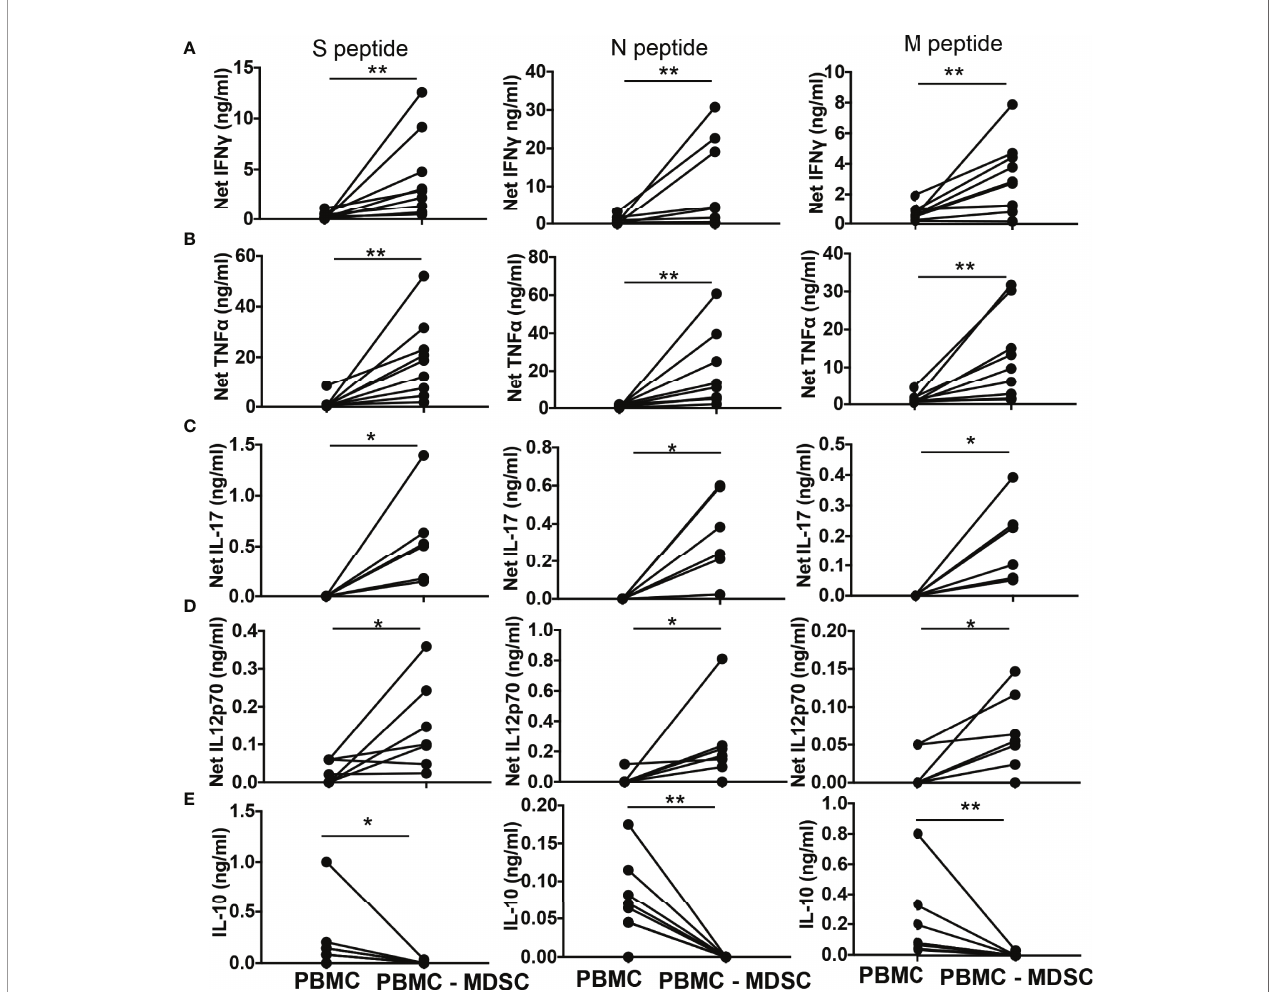
FIGURE 4 | M-MDSC regulates CoV2 antigen-speci fi c T cell cytokine production: (A – E) Freshly isolated PBMC from CoV2+ individuals were stained with anti-CD14 and -HLA DR antibodies; CD14 + HLA DR -/lo M-MDSC were depleted from PBMC by fl ow cytometry. Whole PBMC (PBMC) and MDSC depleted PBMC (PBMC- MDSC) were cultured in the absence or presence of peptide pools of S-, N-, and M- antigens of CoV2 for 48-72 hours. Culture supernatant was stored at -80°C until further use. The quantity of cytokines in the culture supernatant was measured using Bio-Plex multiplex immunoassay system. For all, each dot represents an individual donor. *p < 0.05, **p <